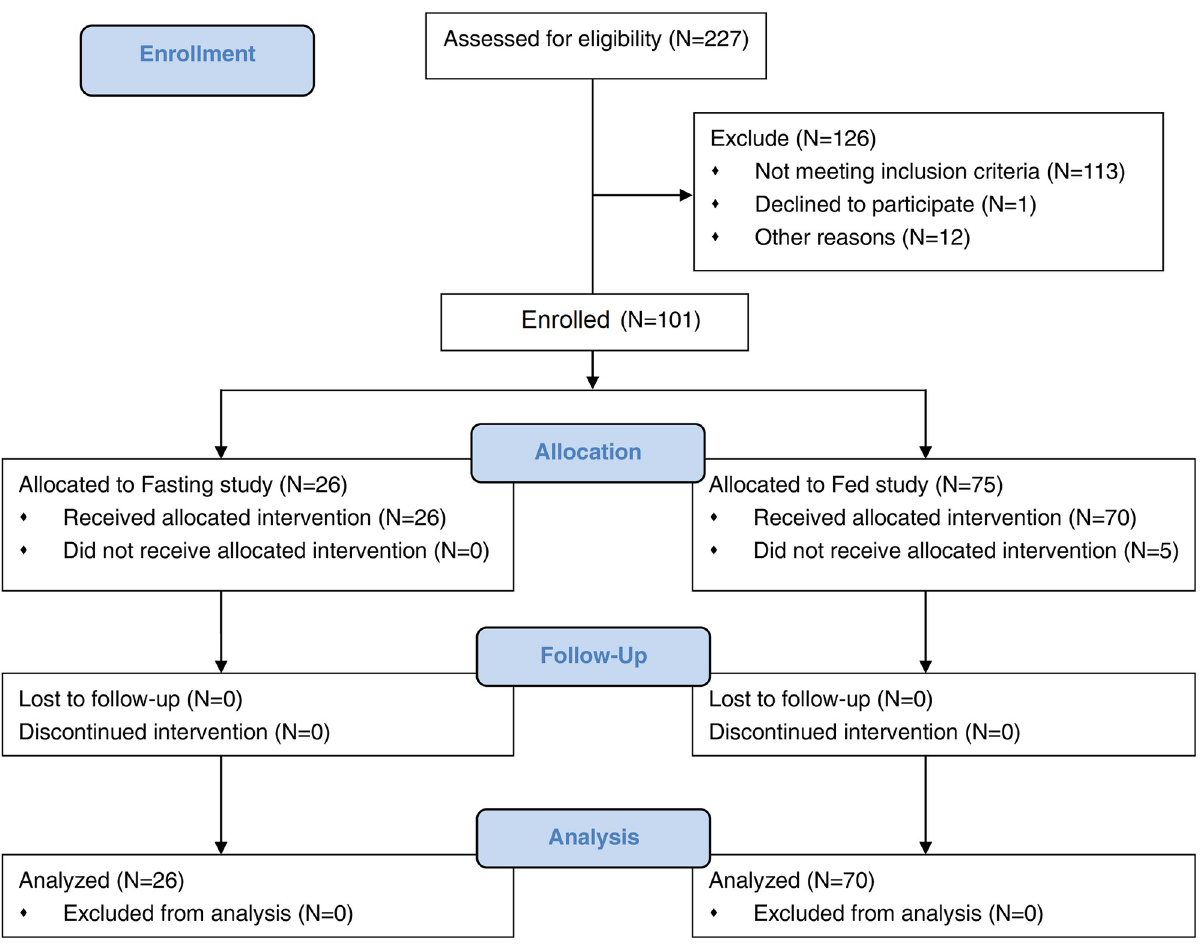
Fig 1. Study flow diagram.